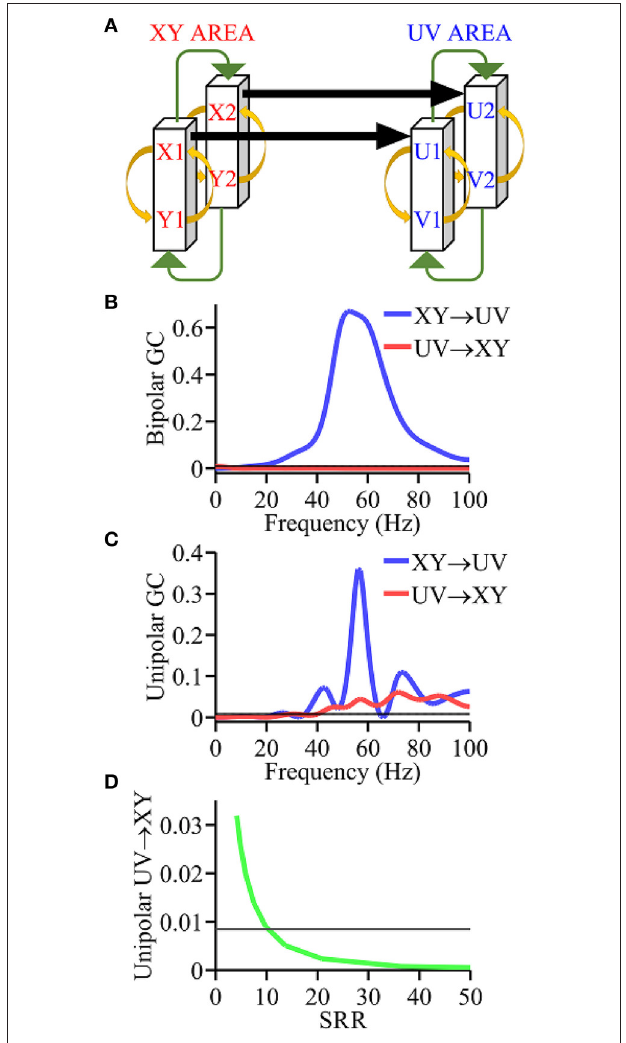
FIGURE 1 | Simulation model. (A) Coupling scheme. (B) Granger causality spectra using bipolar signals which are in agreement with ground truth. (C) Granger causality spectra using unipolar signals which are not in agreement with ground truth. (D) Analysis of the unipolar Granger causality UV → XY as a function of the signal to reference ratio (SRR) (green curve). Black horizontal lines in (B–D) represents the level of statistical significance ( p < 0.05